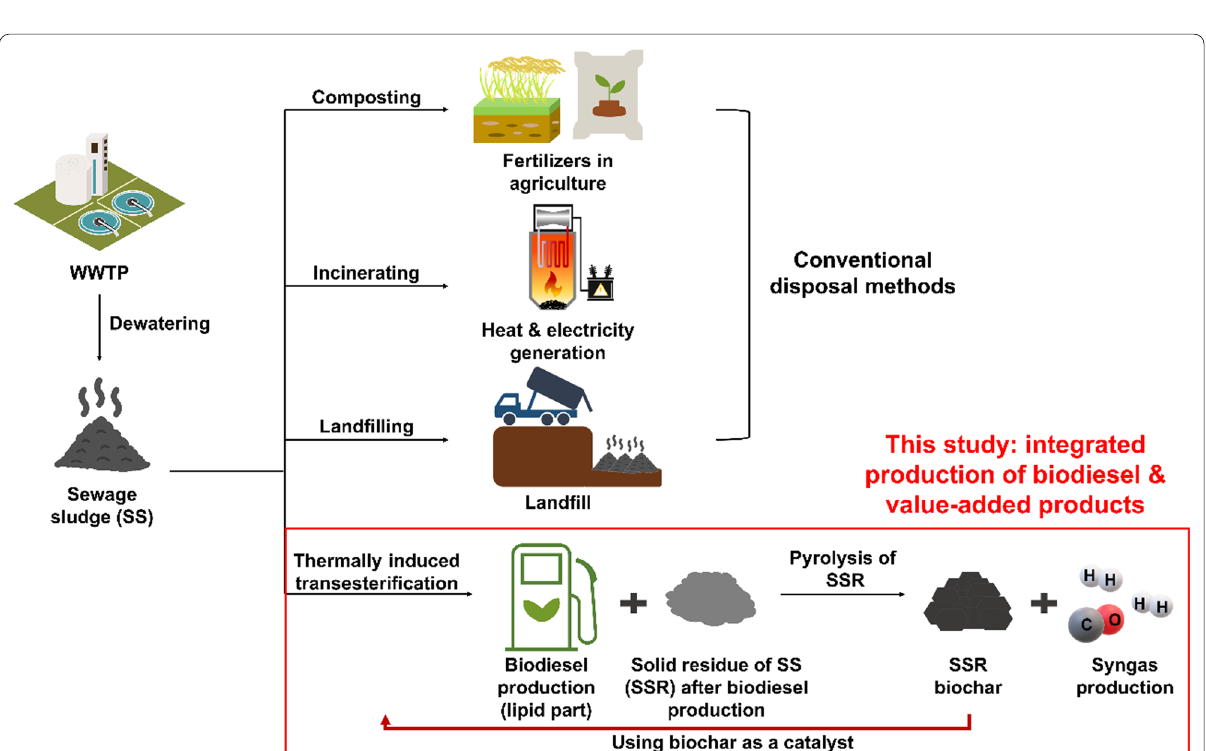
a Average biodiesel conversion yield from SS in summer and winter b